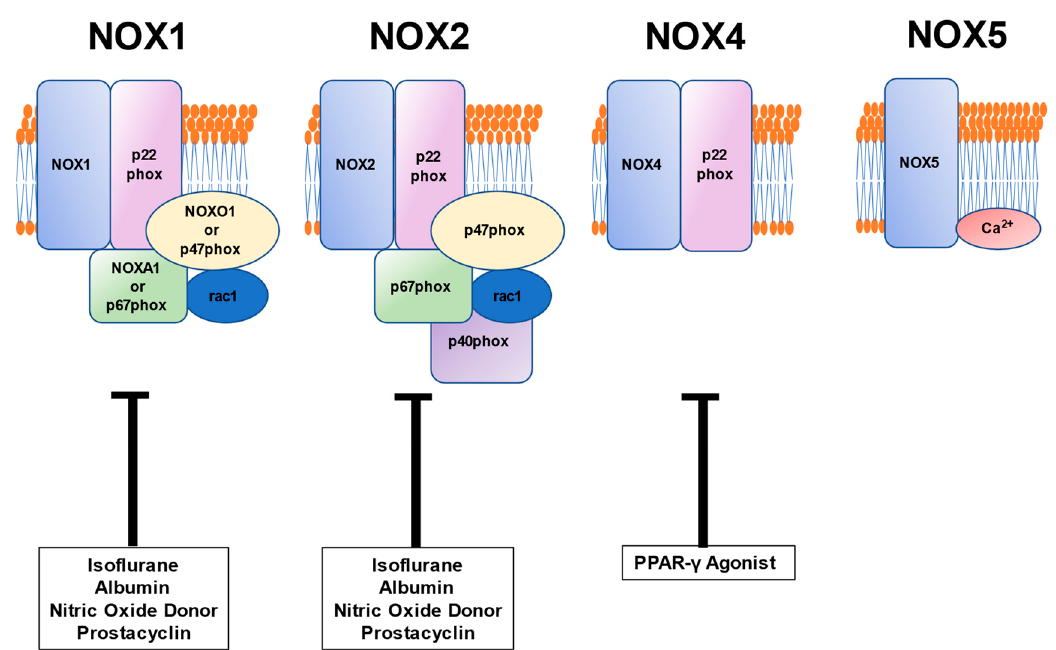
Figure 3. Substances or agents acting on NOXs to reduce the function are shown. Isoflurane, albumin, nitric oxide donor, and prostacyclin possibly inactivate the NOX1 and 2, resulting in decreased oxidative stress in the human vascular smooth muscle cells. In addition, peroxisome proliferator-activated receptor (PPAR)- γ agonists may reduce human vascular oxidative stress since PPAR- γ regulates the NOX4-hydrogen peroxide signaling axis.